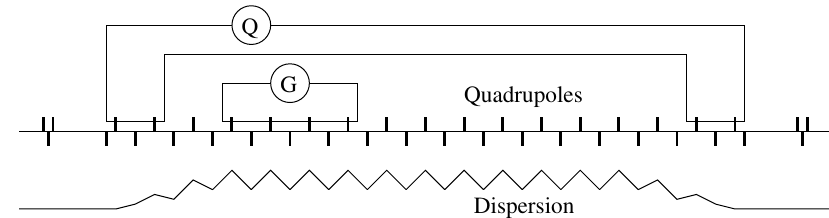
FIG. 2. Arrangement of two (cid:4) quadrupole families in one of the six RHIC sextants for a first-order transition jump t